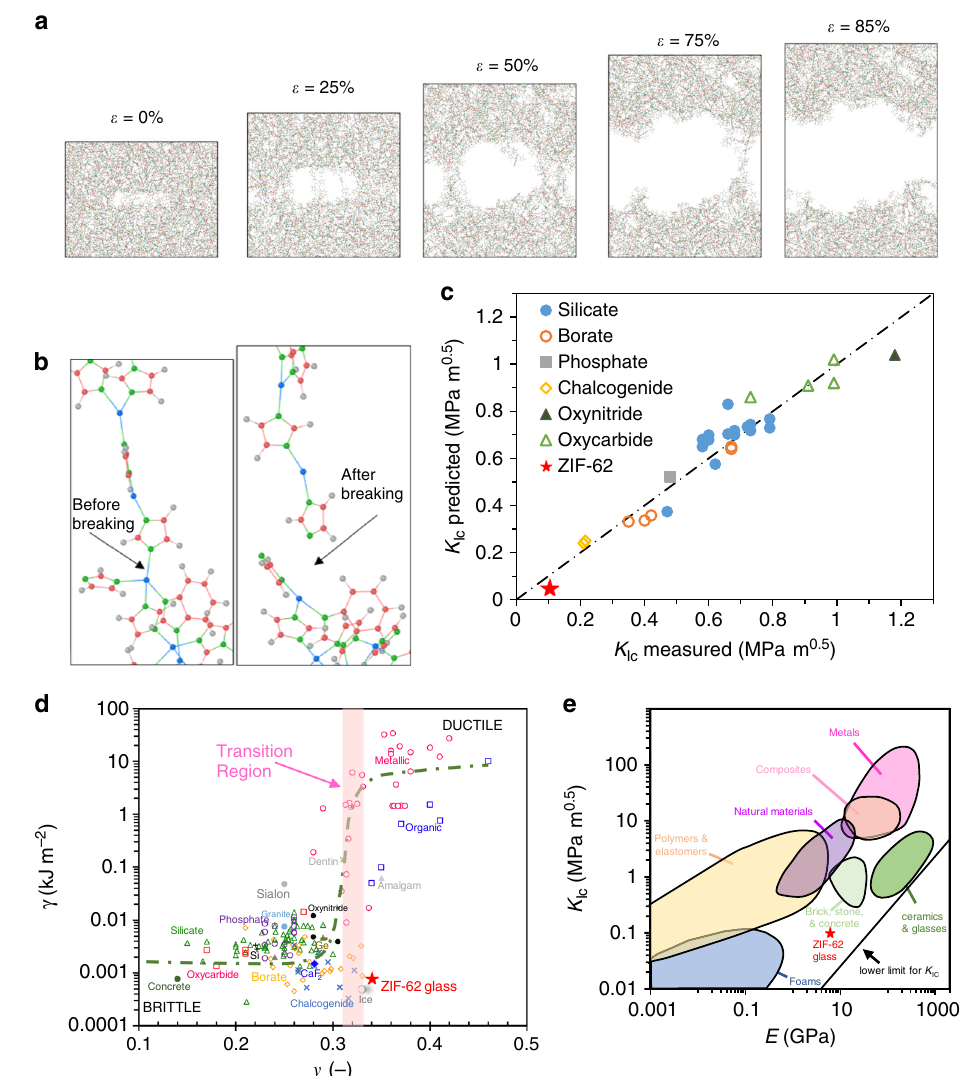
Fig. 3 Fracture mechanism of ZIF-62 glass and comparison with other material families. a Structural representation of the crack propagation in the precracked ZIF-62 glass upon increasing strain ( ε ). Colored spheres represent carbon (red), hydrogen (gray), nitrogen (green), and zinc (blue). b Enlarged view of the Zn – N bond before (left) and after breaking (right). c Comparison of theoretically predicted and experimental fracture toughness ( K Ic ) for a range of glass and glass-ceramic materials. The theoretical prediction is explained in the text. Figure is adopted with data from ref. 44 , in addition to data for silicate and borate glasses 54 , oxycarbide glass-ceramics 45 , and the present ZIF-62 glass. All the experimental K Ic values are from self-consistent methods such as SEPB, chevron notched beam, and surface cracked in fl exure, with an error smaller than ±0.05 MPa m 0.5 . d Relationship between fracture surface energy ( γ ) and Poisson ’ s ratio ( ν ) for a range of materials. Figure is adopted with the data from refs. 48,49,62 and extended with additional data for metallic glass ceramics 45 , tellurite glass 70 , and the present ZIF-62 glass. e Ashby plot of the relation between K Ic and Young ’ s modulus ( E ) for a range of materials. The fi gure is adopted with data from ref. 75 and extended with that of the present ZIF-62 glass. Source data are provided as a Source Data fi